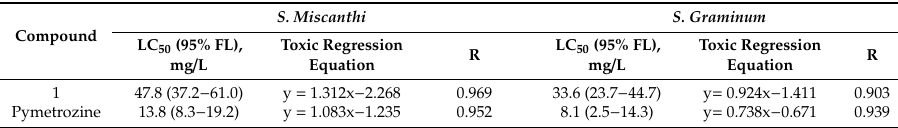
Figure 3. Structure features of neonicotinoids. Table 5. The LC 50 of Compound 1